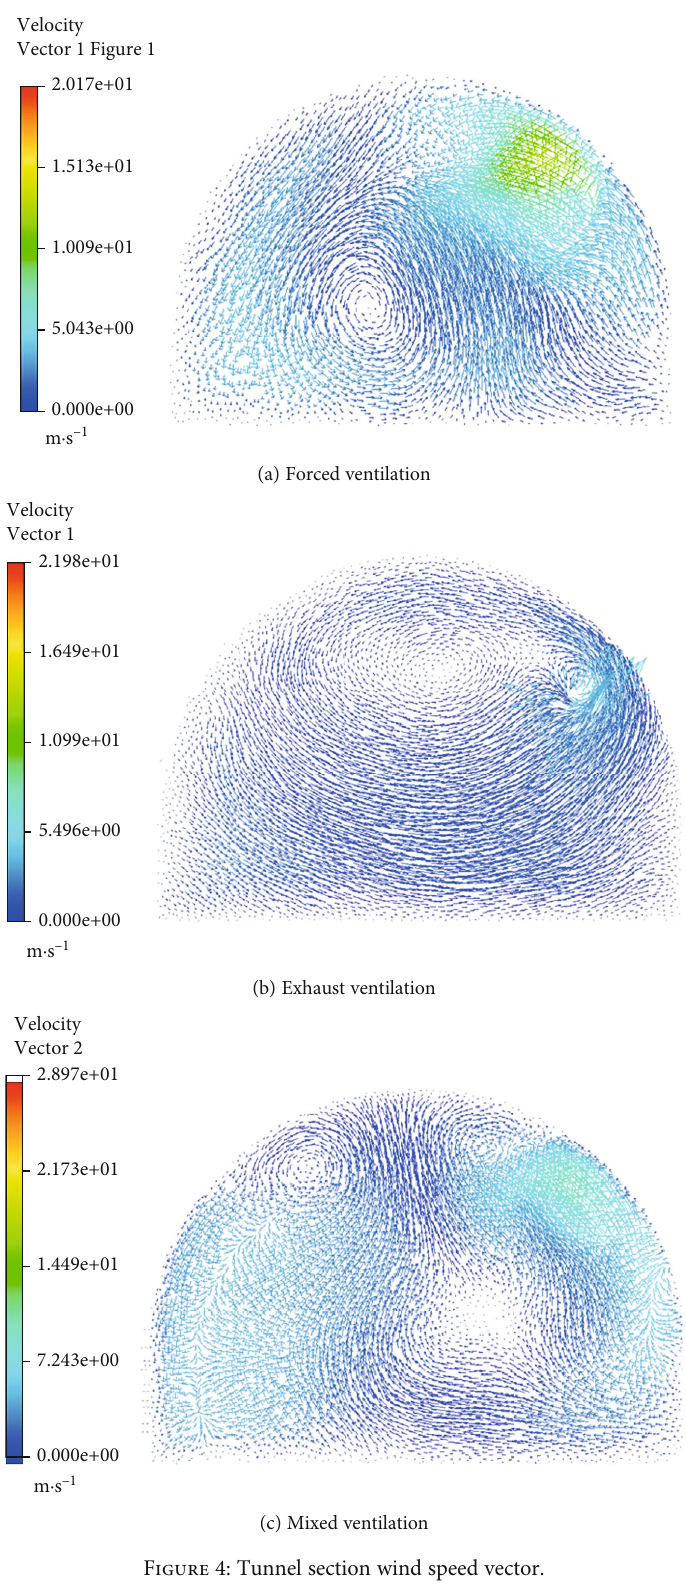
Figure 4: Tunnel section wind speed